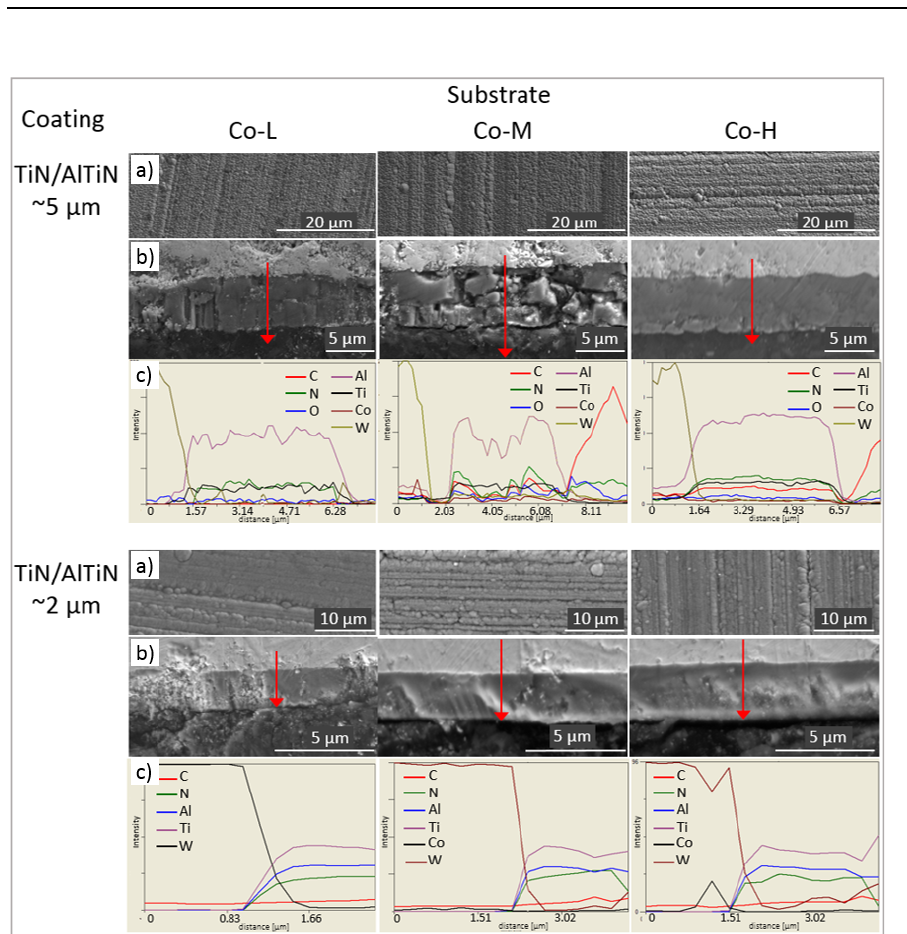
Figure 5. Morphology ( a ), metallographic cross-section SEM images ( b ) and EDX line scan compo- sition profiles ( c ) of TiN/AlTiN nanolayer coatings deposited on Co-L, Co-M and Co-H